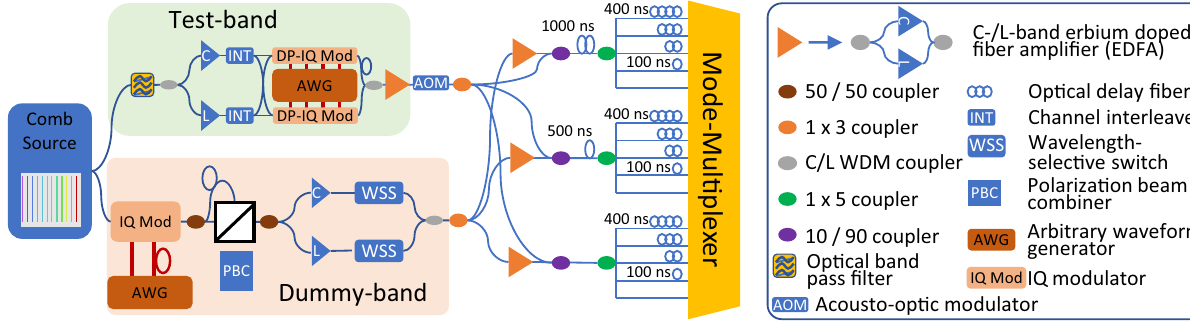
Fig. 6 Laboratory implementation of the transmitter setup. The output of the comb source was modulated in two sub-systems, one for a high-quality tunable test-band and one for dummy channels. Fifteen de-correlated copies of the signal were generated in a split-and-delay stage to emulate independent data channels in each fi ber